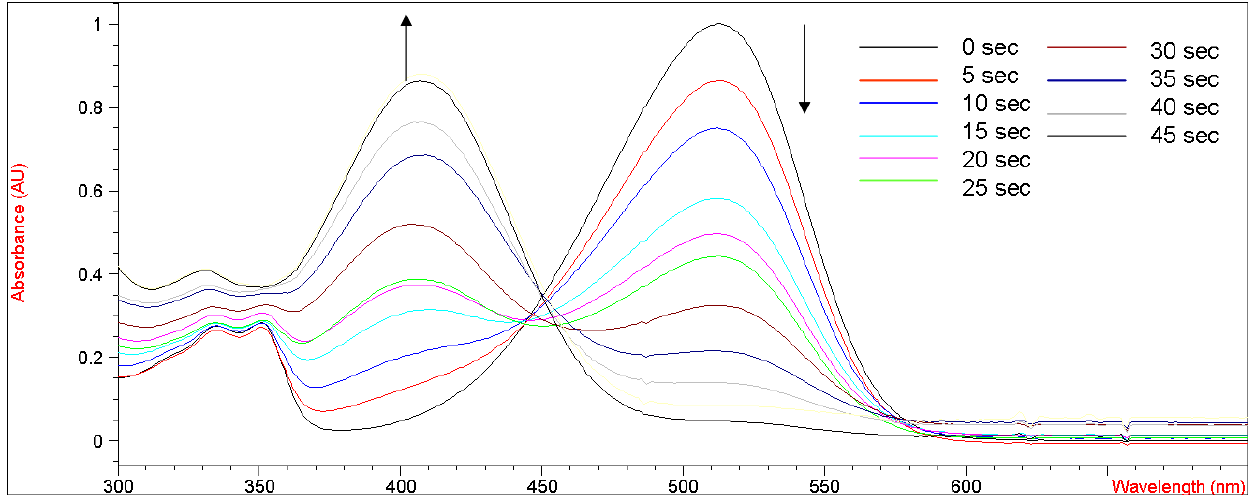
(g) in CH Cl . 3 2 2